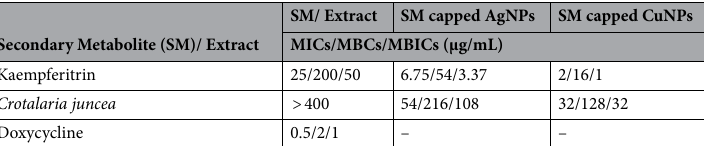
Table 3. Screening of C. juncea extract /secondary metabolite and capped metallic nanoparticles against Methicillin-resistant Staphylococcus aureus